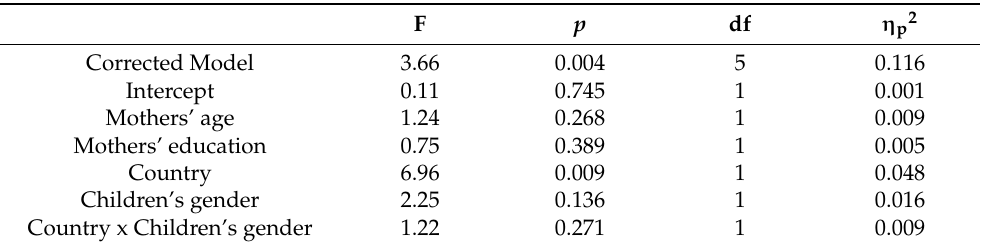
Table 3. Main and interaction effects (ANCOVA) of mothers’ country and children’s gender predicting mothers’ regulatory talk at 12 months (controlled for mothers’ age and education).